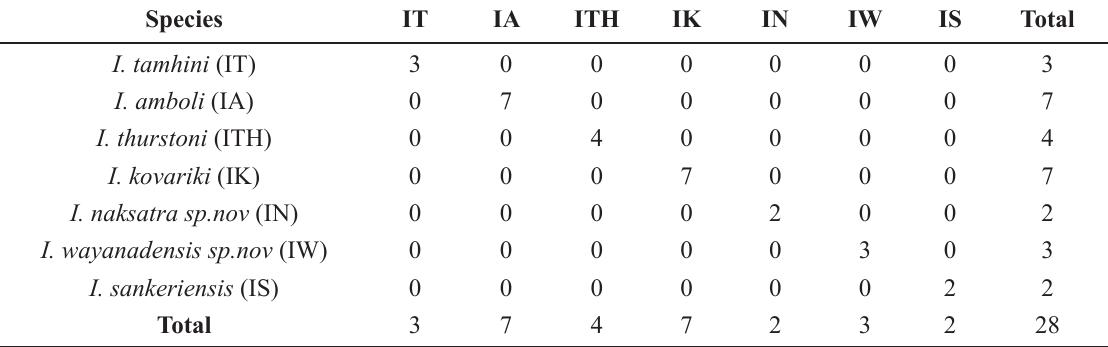
Table 8. Classification matrices for discriminant function